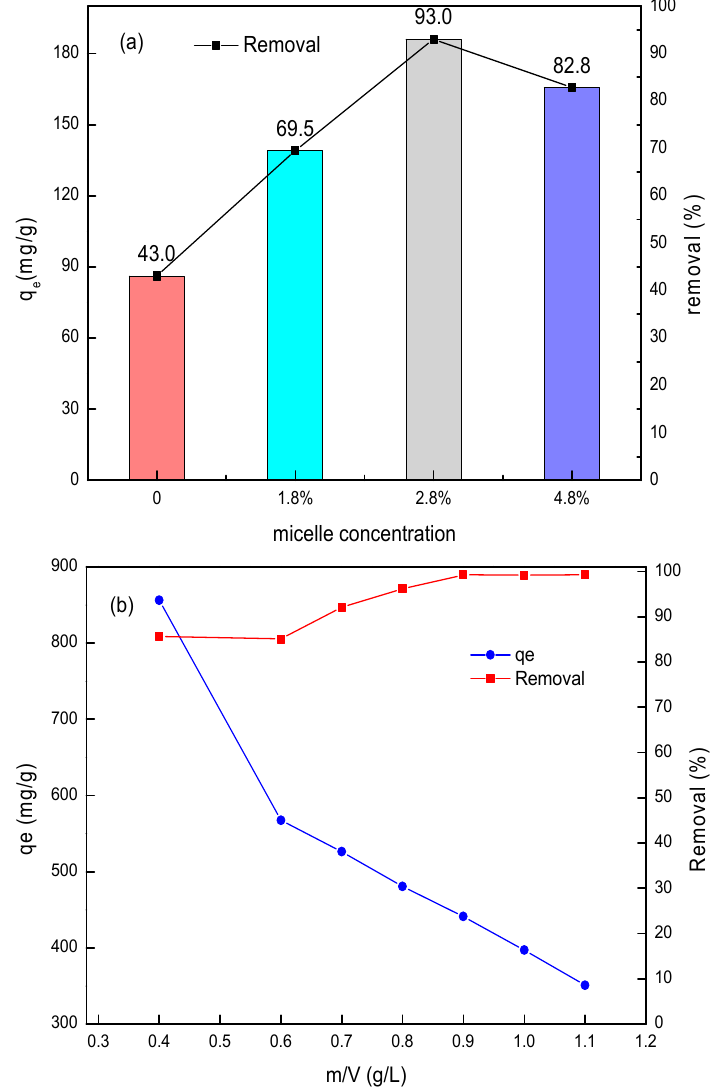
Figure 4. ( a ) Effect of surfactant concentrations on sulfonated lignite (SL) adsorption and ( b ) effect of adsorbent dosage on SL adsorption using 2.8%CB-LDH (conditions: initial SL concentration of 100 mg/L, 25 °C, pH = 7, and contact for 1.5 h).